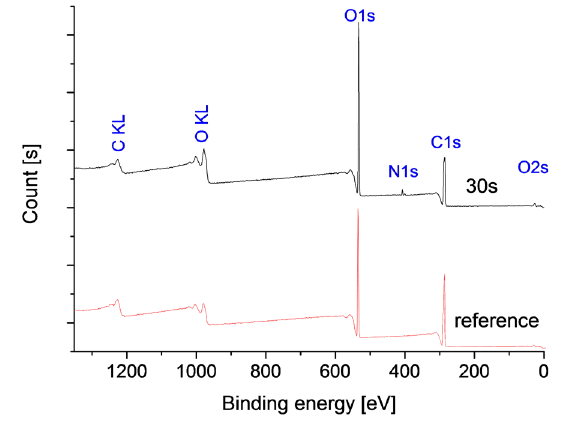
Figure 5 : PLA XPS survey spectra: untreated (lower) and treated 30 s (upper).